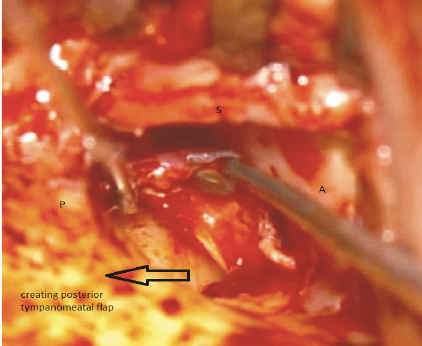
Figure 5: Final result after placement of the